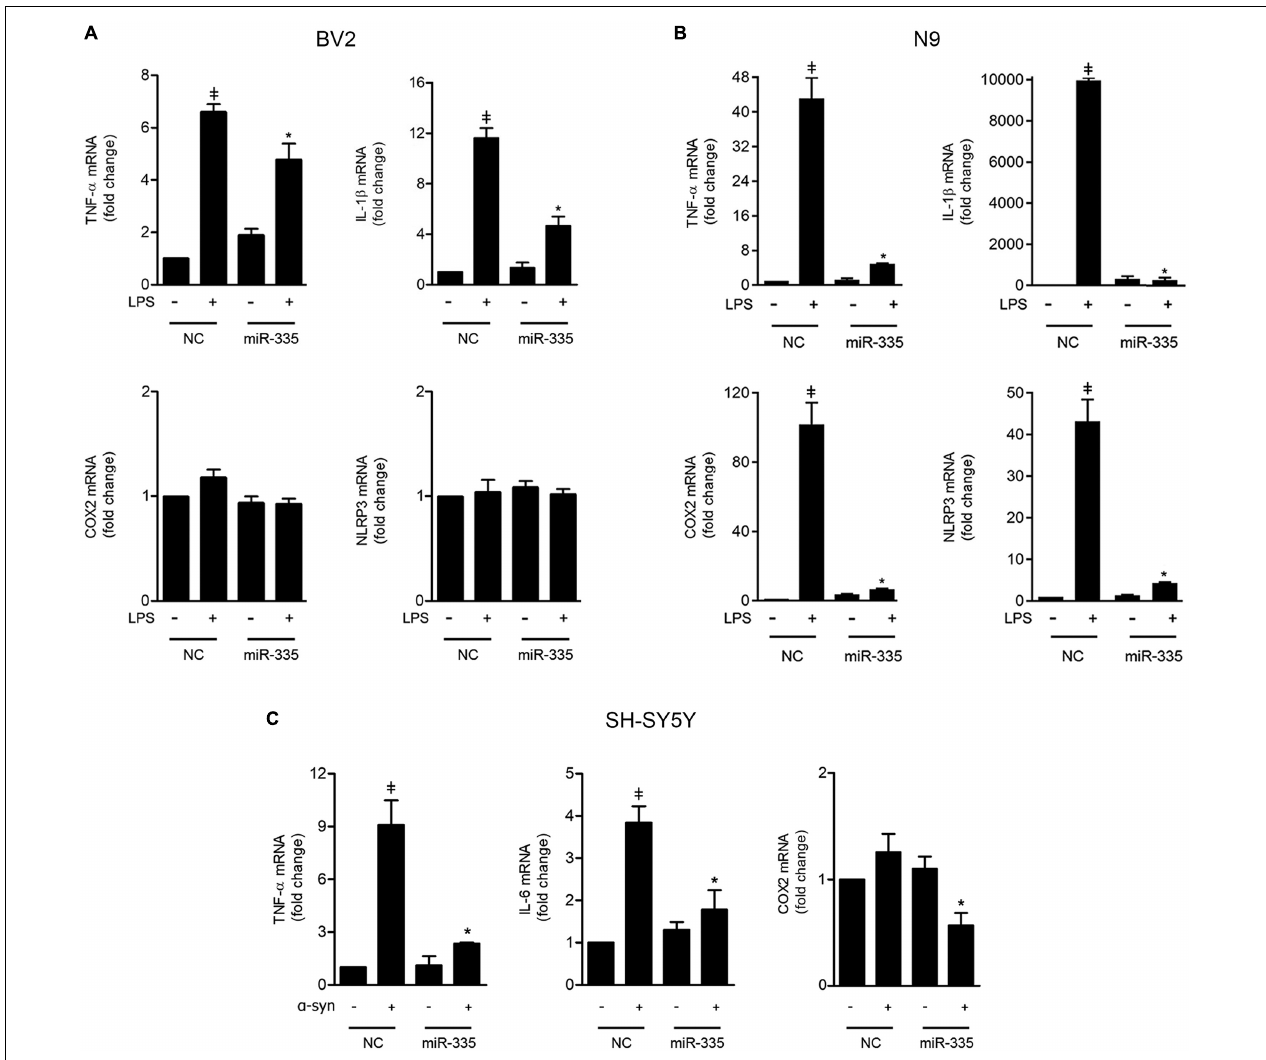
FIGURE 3 | Modulation of LPS or α -syn-mediated proinflammatory mRNA levels by miR-335. BV2 (A) and N9 (B) cells were transfected with a pre-miR-335 or pre-NC for 24 h, and then stimulated with LPS for additional 24 h. (C) SH-SY5Y cells with or without overexpression of α -syn were transfected with a pre-miR-335 or pre-NC for 24 h. mRNA levels were measured by qRT-PCR. Results are expressed as mean ± SEM from three independent experiments. } p < 0.01 vs. NC; * p < 0.05 vs. NC overexpressing α -syn or NC exposed to